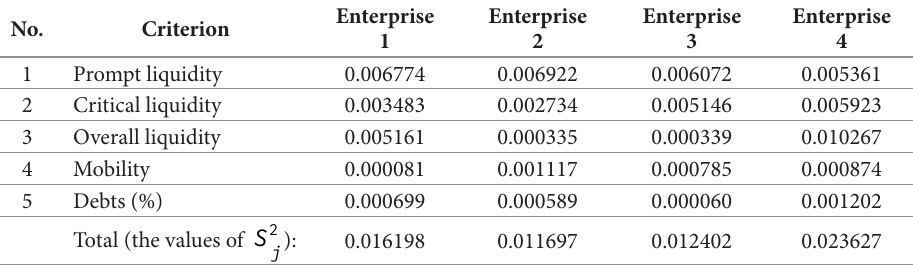
Table 6. The values of the squares of the sectors ω